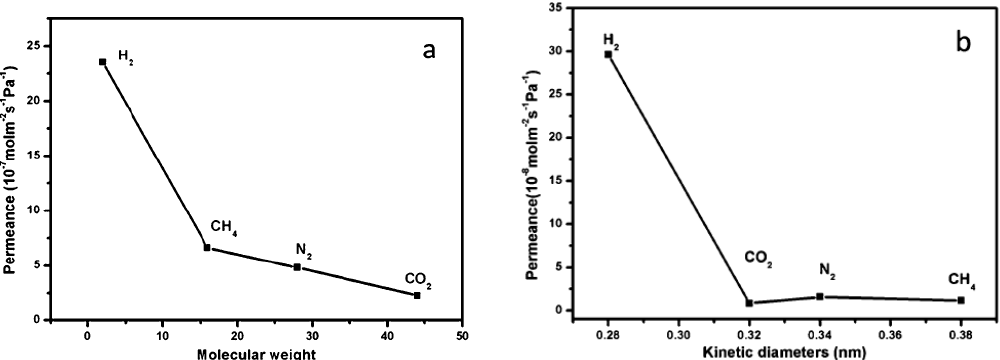
Figure 39. ( a ) Schematic diagram of the preparation of Ni 2 (L-asp)2P (P = bipy or pz) membranes on nickel screens. ( b ) Schematic description of compound 1 and JUC-150 structure. Ni cyan, C gray, N blue, and O red; the H atoms are omitted for clarity (adapted with permission from ref. [136]).